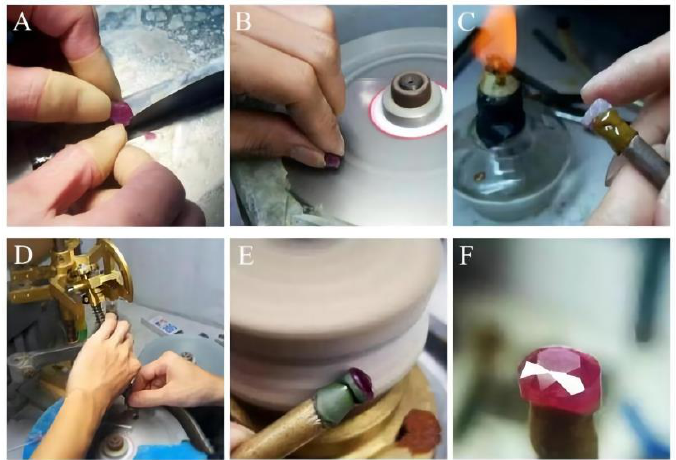
Figure 2. Process of hand-cut faceted imitation gemstone glass: ( A ) opening; ( B ) shaping; ( C ) gluing; ( D ) grinding; ( E ) polishing; and ( F ) final product.